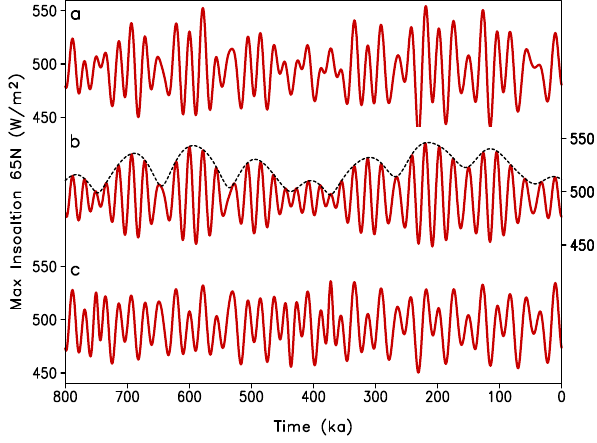
Fig. 7. Maximum summer insolation at 65 ◦ N in (a) the BE, CC n and REG n experiments, (b) the experiment with constant obliquity (COB n ) and (c) constant eccentricity ( e =0.02, CEC n /0.02). The dashed line in panel (b) shows the amplitude modulation of the pre- cessional cycle by